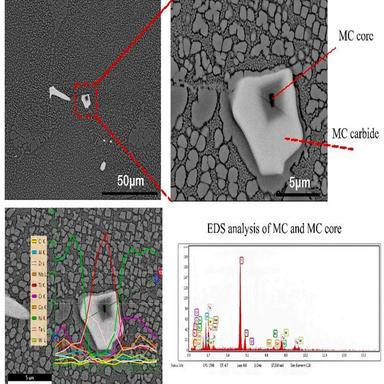
MC carbide and EDS analysis of the MC core.